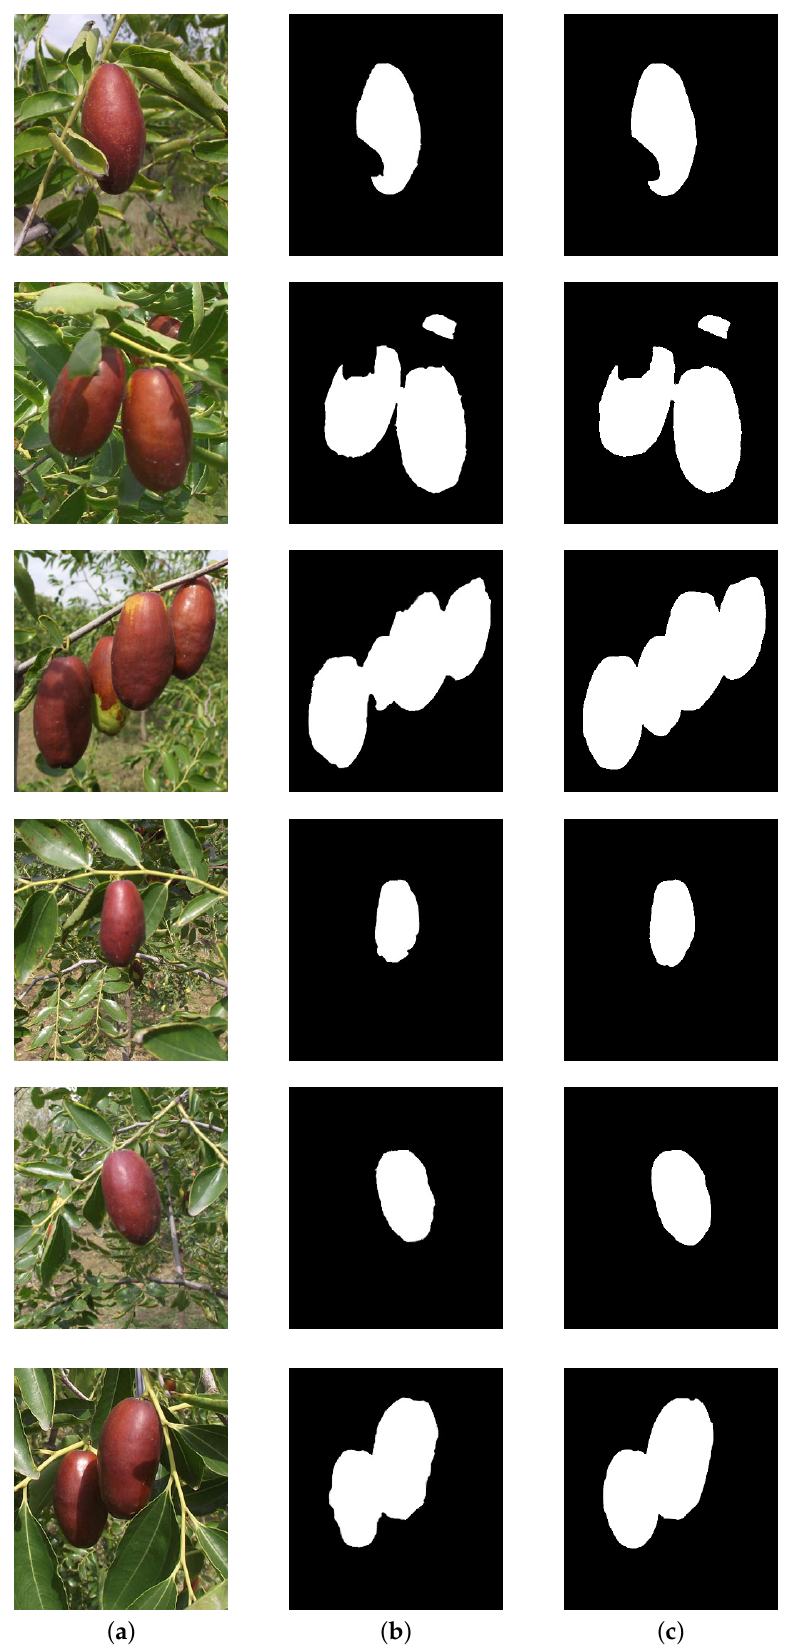
Figure 18. Segmentation results of long jujubes. ( a ) Original image. ( b ) Proposed marker-controlled watershed algorithm. ( c ) Artificial